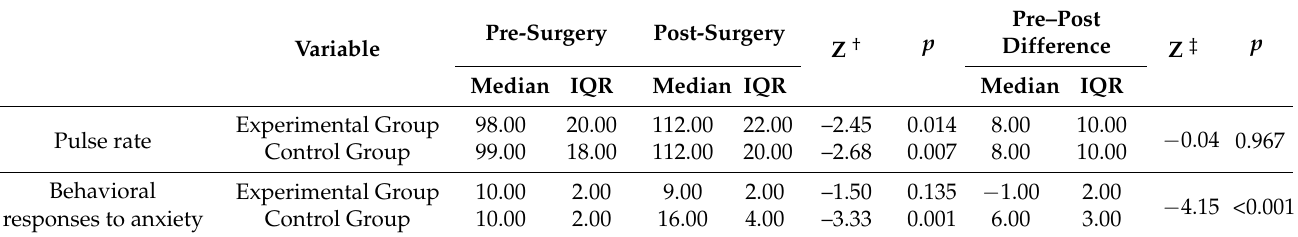
Table 4. Homogeneity of baseline study